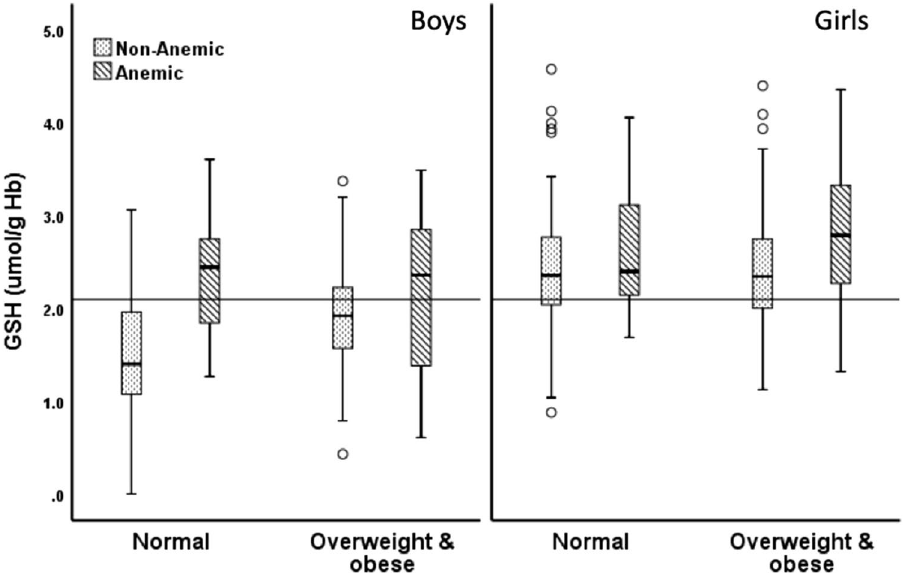
Figure 2. Reduced glutathione (GSH) levels in relation to the anemia